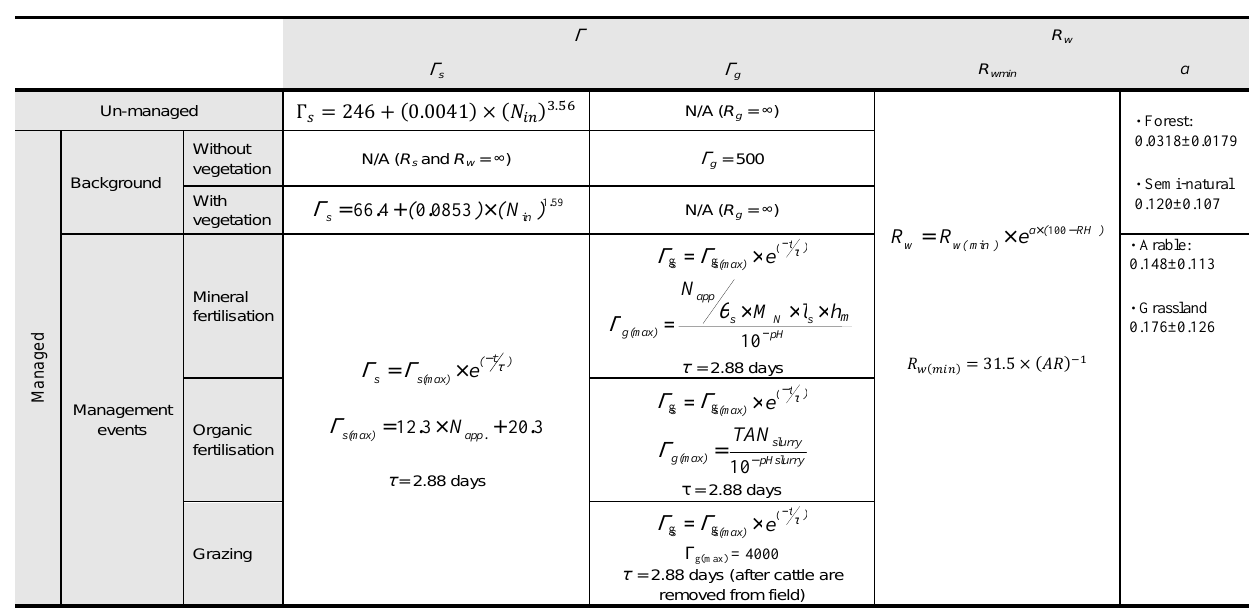
Table 8. Summary of the proposed parameterisation of a two-layer NH 3 bi-directional exchange